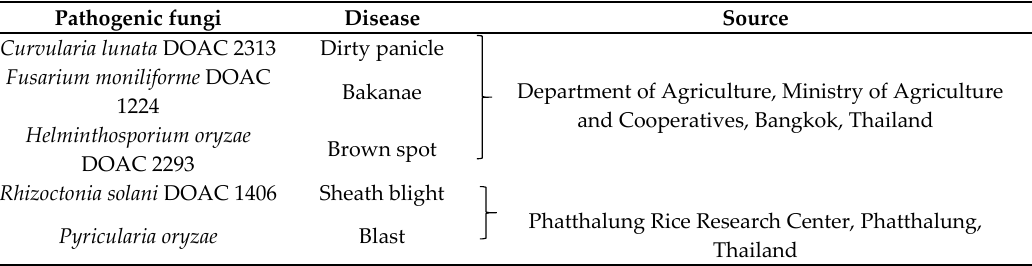
Table 2. Rice pathogenic fungi used in this study.